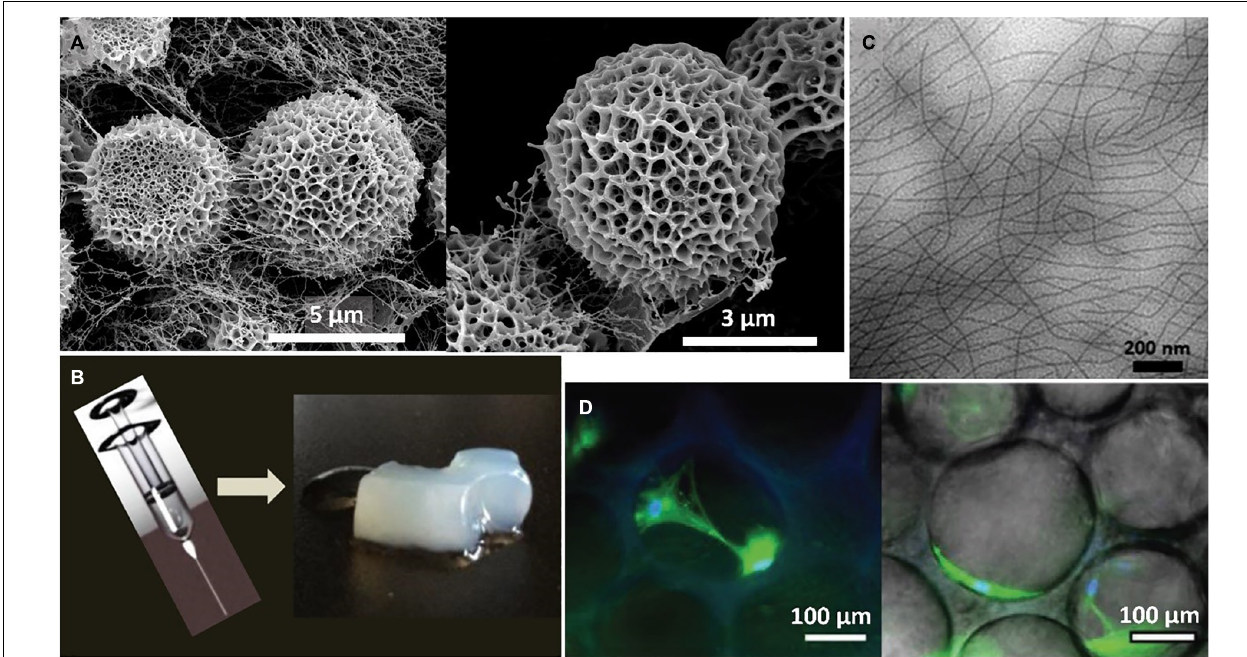
FIGURE 3 | (A) Representative SEM images of the self-assembled biomorphs generated by EI-silk-VKV SELR from 2 mg mL-1 aqueous solutions after 48 h at 37 ◦ C reproduced with permission from (doi.org/10.1002/smll.202005191), copyright 2020. (B) Representative macroscopic images of the self-assembled hydrogel generated by (EIS)2 SELR from 150 mg mL-1 aqueous solutions after 60 days at 37 ◦ C reproduced with permission from (doi.org/10.1021/bm501051t2014), copyright 2014. (C) Representative TEM images of the self-assembled fibers generated by (EIS)2-(I5R)6 SELR from 3 mg mL-1 aqueous solutions after 48 h at 37 ◦ C reproduced with permission from (doi.org/10.1021/acs.biomac.8b01211), copyright 2018. (D) Representative microscopic images of the self-assembled hydrogel generated by I 20 K 2 -RGD-K 2 S 6 I 20 from 175 mg mL − 1 aqueous solutions after 14 days post-seeding with human mesenchymal stem cells (hMSCs) at 37 ◦ C reproduced with permission from (doi.org/10.1002/smll.202001244), copyright